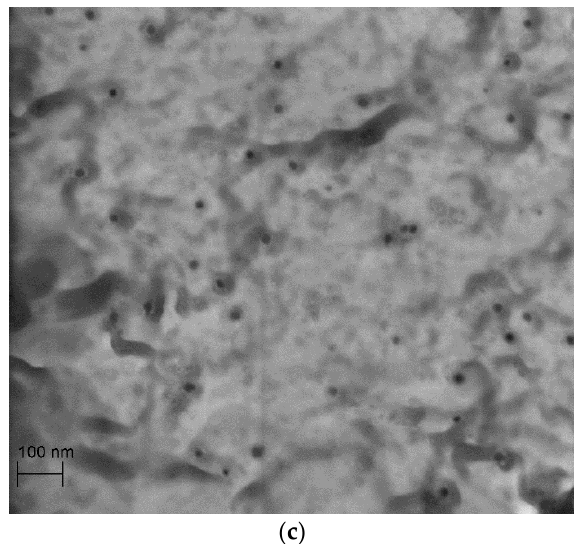
Figure 5. Evaluated MFS from the measured rolling force for steel 0 Nb and 240 Nb. ( a ) MFS during the complete rolling phase in austenite region. ( b ) MFS detail on final reductions. In the case of 0 Nb, the rolling is performed only in the Type I region as T nr is below FRT, see Table 2. ( c ) STEM visualization of small (dark) nanosized particles of Nb(C,N), randomly distributed, observed on a carbon replica in average size of 8.2 nm with a maximum sized up to 16.3 nm for 240 Nb. Accelerating voltage: 30 kV.